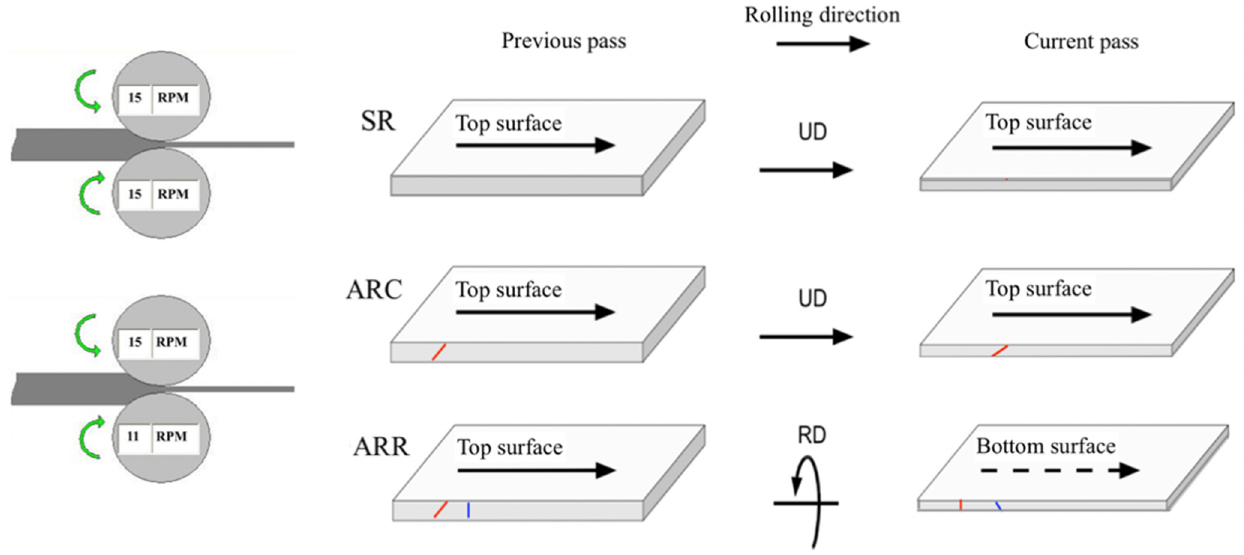
Figure 3. Rolling routes employed in the present work. SR—symmetric rolling; ARC—continuous asymmetric rolling (no rotation of the sheet between two subsequent passes); ARR—reverse asym- metric rolling (rotation around the rolling direction between two subsequent passes).